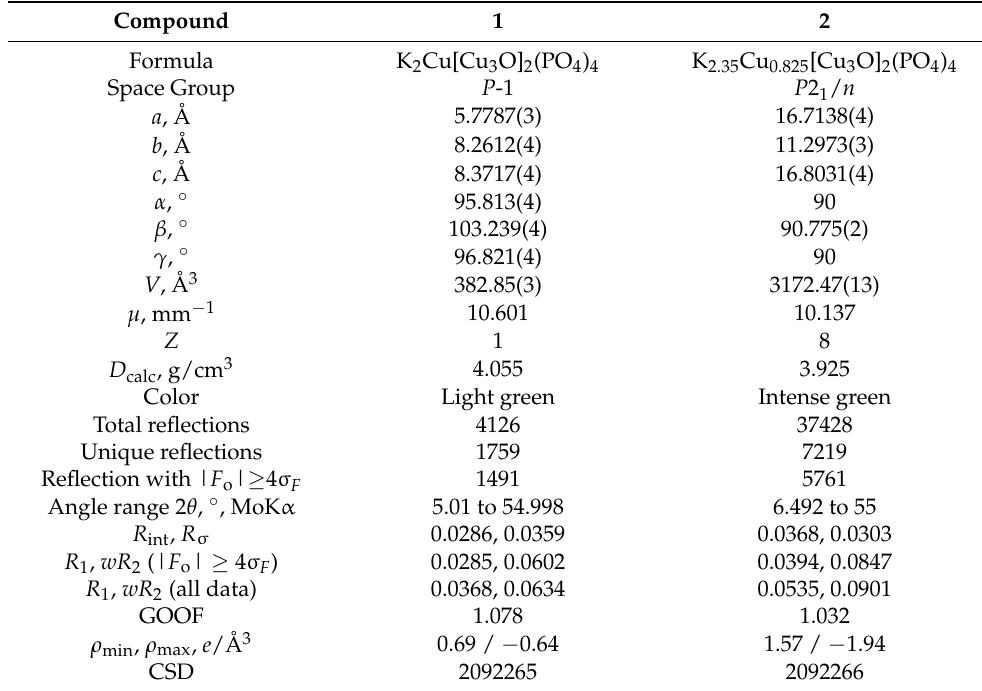
Table 1. Crystallographic data and refinement parameters for 1 and 2